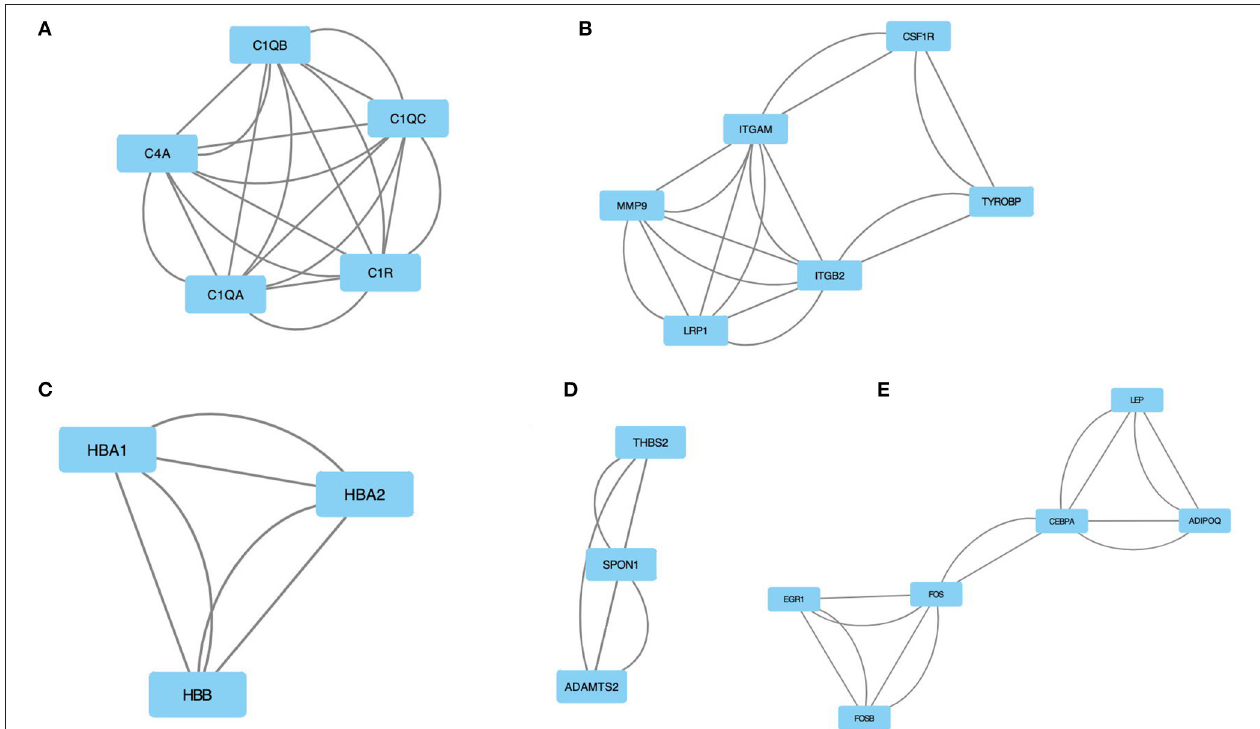
FIGURE 4 | The module identified from the PPI network using the MCODE method is shown in this figure. (A) Module 1 with an MCODE score of 5. (B) Shows module 2 with an MCODE score of 3.6. (C) The module 3 with an MCODE score of 3. (D) The module 4 with an MCODE score of 3. (E) The module 5 with an MCODE score of 2.8. MCODE, molecular complex